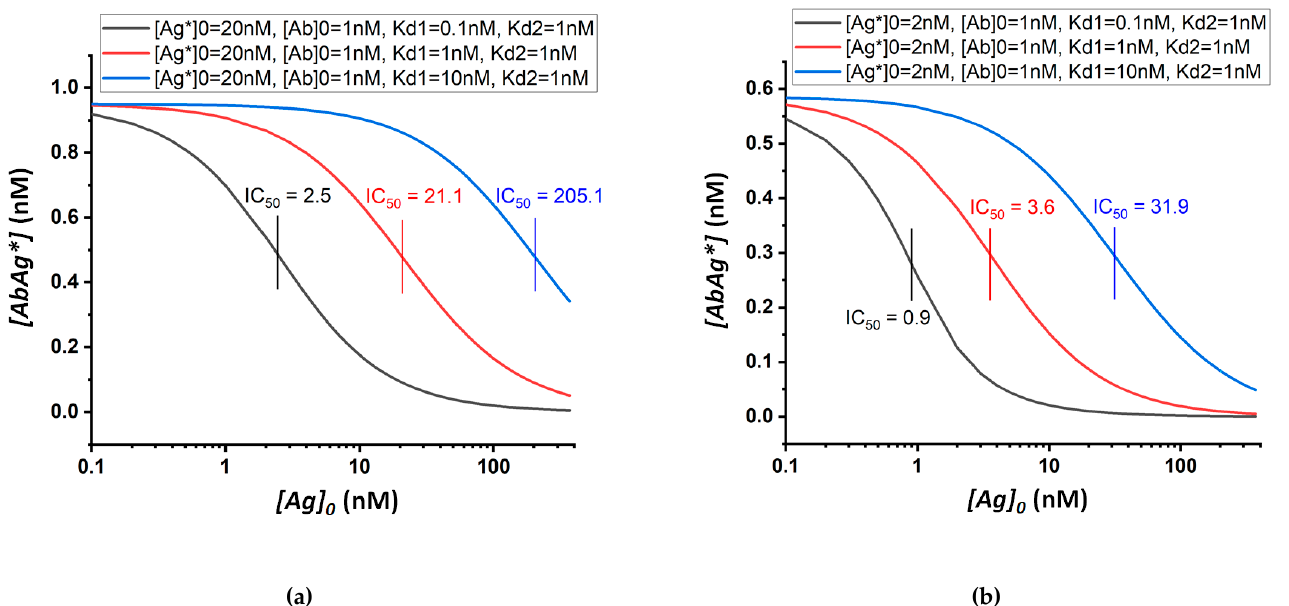
Figure 1. Theoretical calibration dependences of equilibrium competitive immunoassay at different values of the equilibrium dissociation constant of the antibody–unlabeled-antigen complex. The quantities inserted into Equation (15) are shown in the sidebars. ( a ) shows the variance of the constant K d1 from 0.1 to 10 nM at [ Ag *] 0 = 20 nM; ( b ) shows the same variance of the K d1 constant at [ Ag *] 0 = 2 nM.